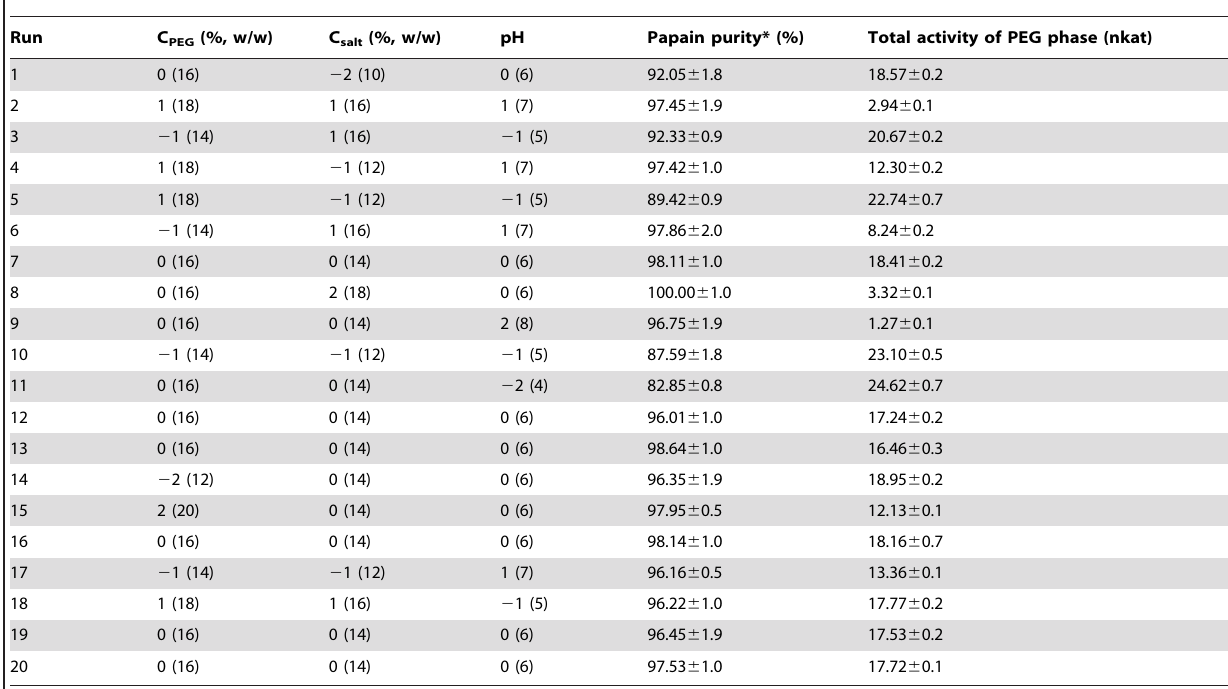
Table 2. Design matrix for optimization of papain purity and total activity using CCD.